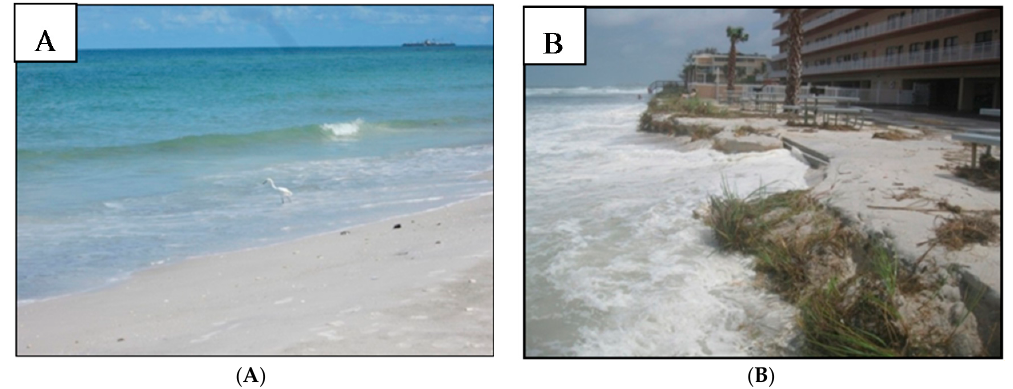
Figure 2. Study area under normal weather condition ( A ), as well as under Tropical Storm Debby in 2012 ( B ).